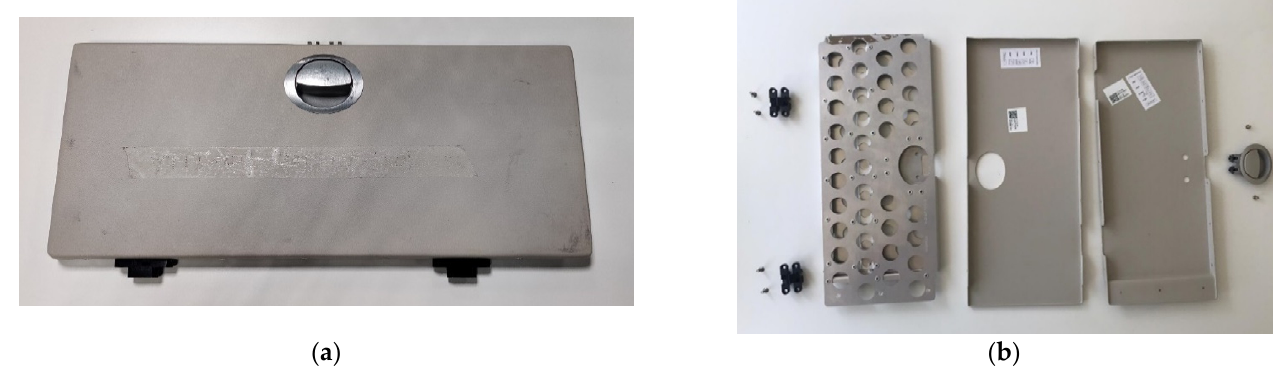
Figure 11. Seat folding table ( a ) and inside the structure of the seat folding table ( b ).